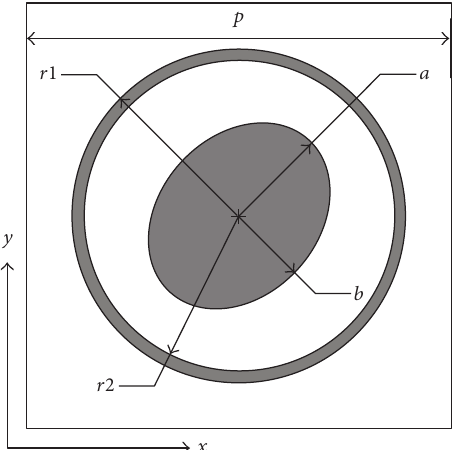
Figure 5: The structure of the ring/disk